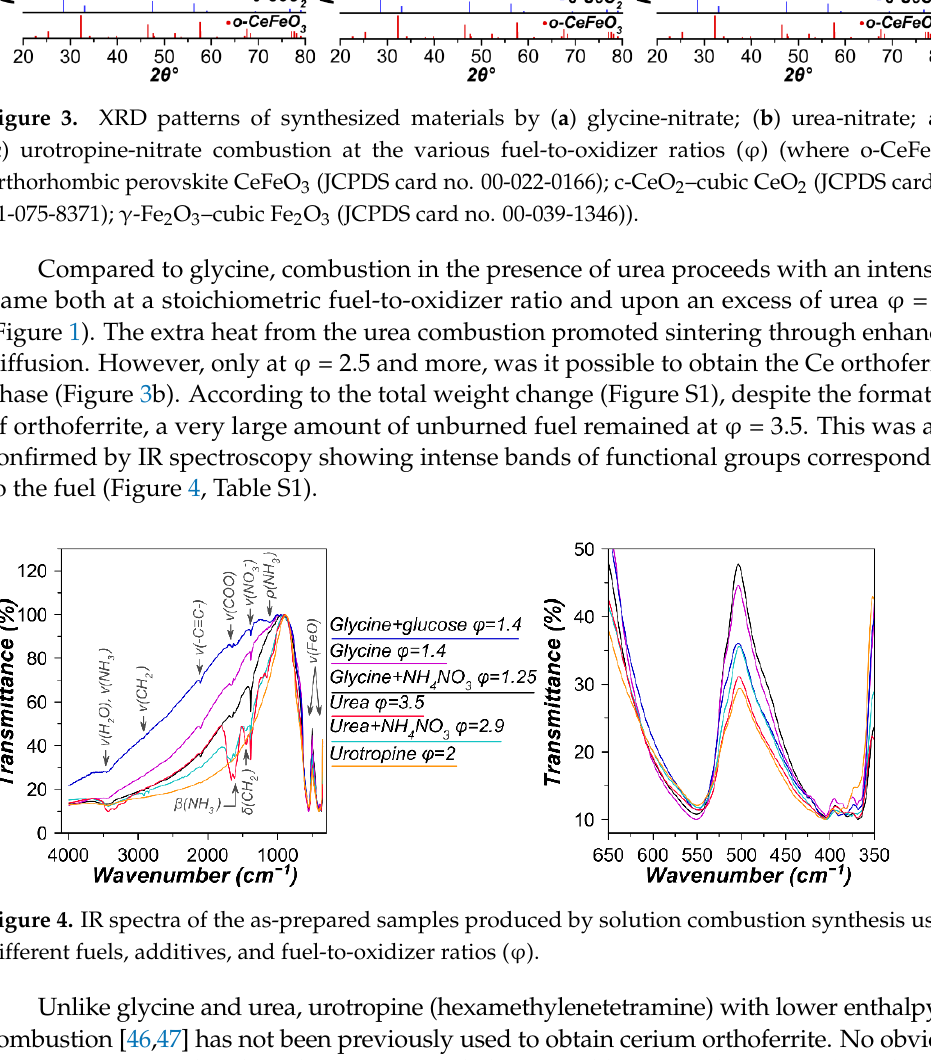
Figure 4. IR spectra of the as-prepared samples produced by solution combustion synthesis using different fuels, additives, and fuel-to- oxidizer ratios (φ).